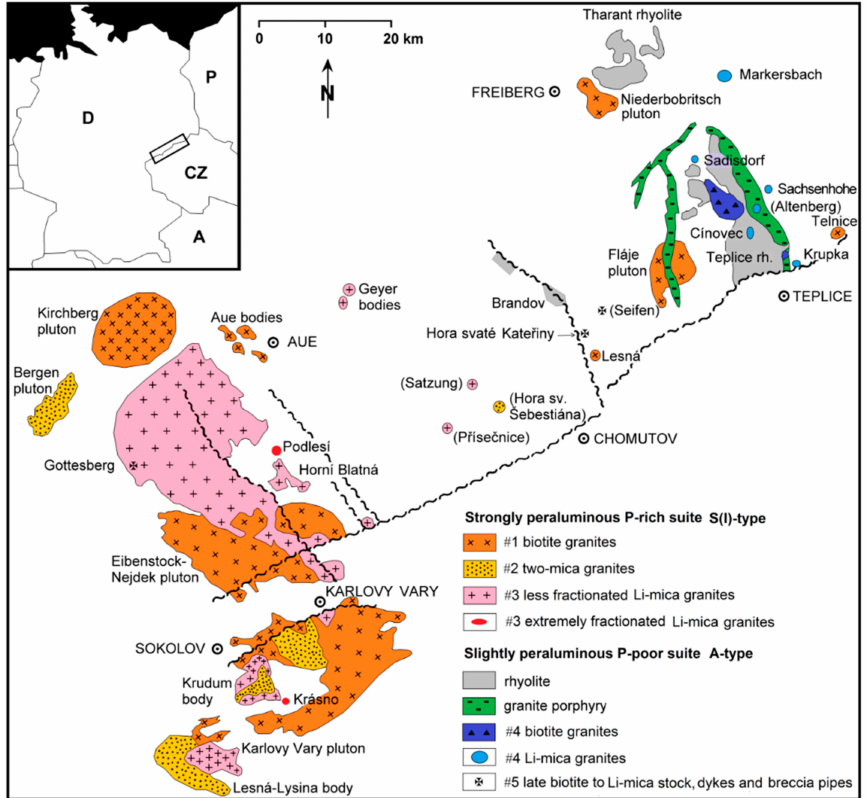
Figure 1. A sketch of the distribution of late Variscan granites in the Erzgebirge/Krušn é Hory and adjacent Slavkovsk ý Les area. Classification of granites into five geochemical groups according to [12]. Names of hidden bodies known only from boreholes or mines are given in